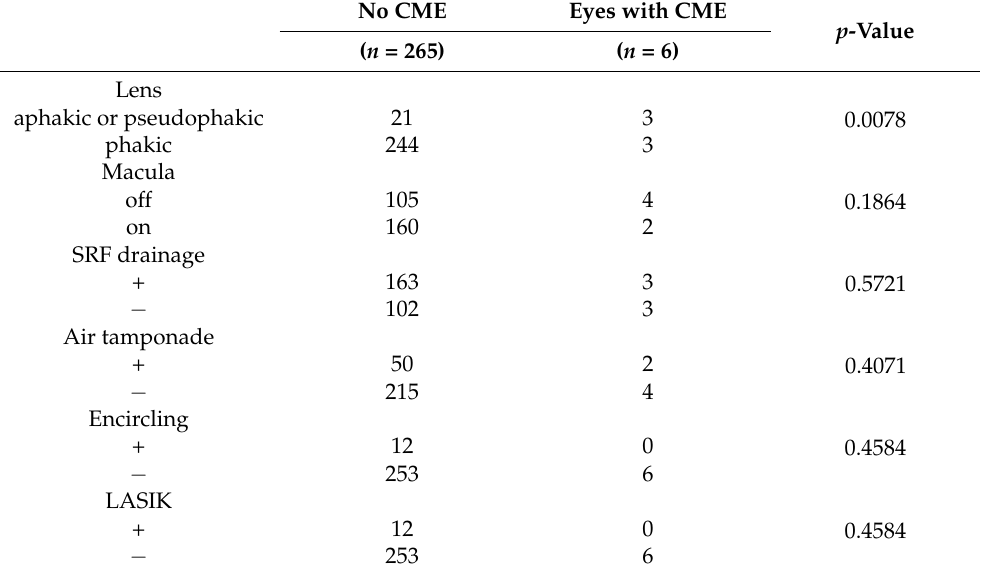
Table 2. Factors associated with cystoid macular edema after scleral buckling surgery.